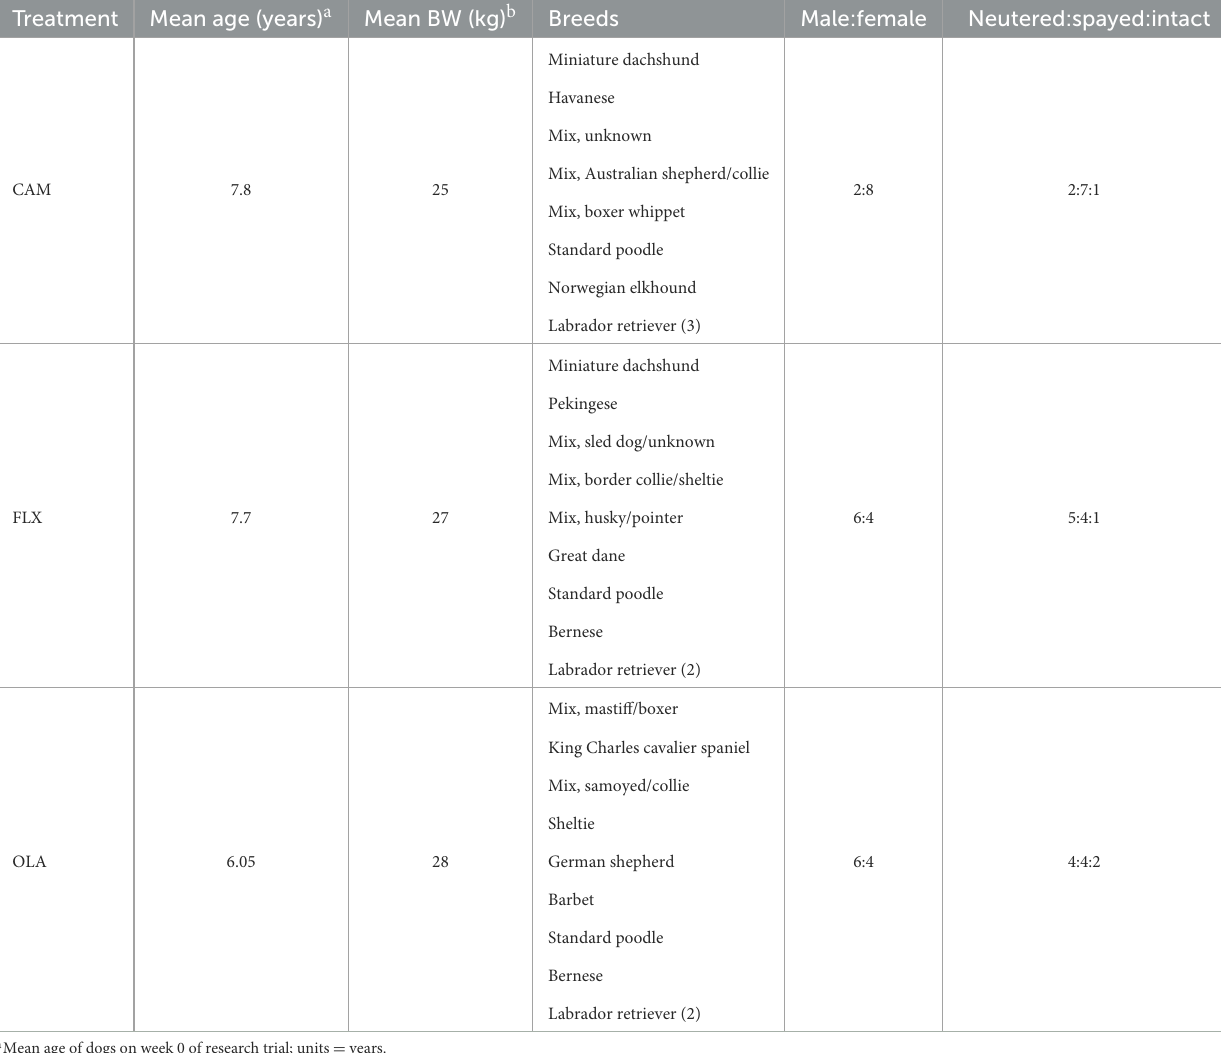
TABLE 1 Mean age, mean body weight, breeds, and male:female and neutered:spayed:intact ratios of 30 client-owned dogs enrolled in a research trial investigating the effects of three oil supplements (camelina, canola, flaxseed) on transepidermal water loss, inflammatory and oxidative markers, and coat quality over a 16-week